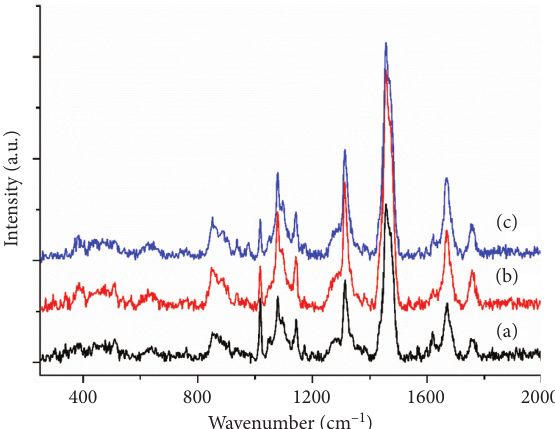
Figure 1: Raman spectra of brand XX (a), brand YY (b), and brand ZZ (c) cheese products, respectively. Table 1: The main Raman vibrational bands and their respective tentative assignments.